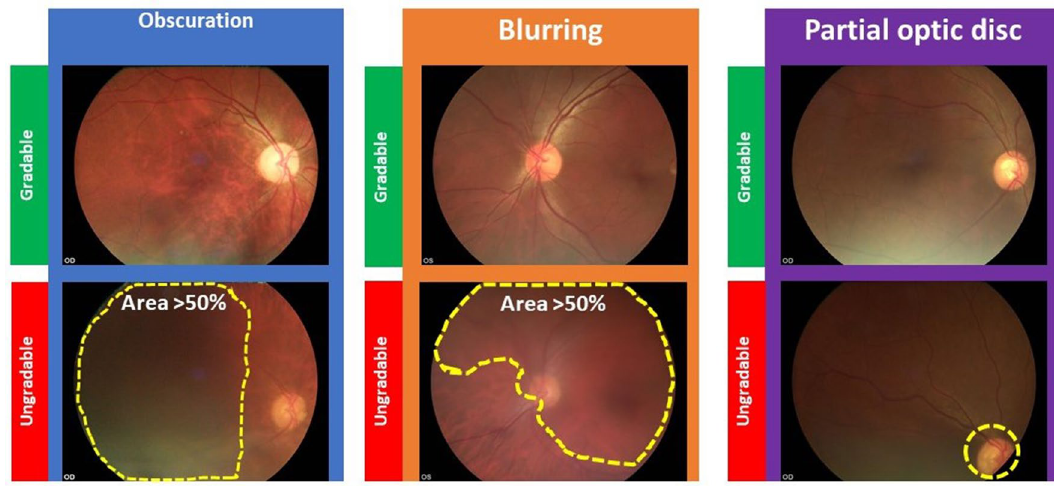
Figure 2. Gradability definition examples. OD Right eye, OS : Left